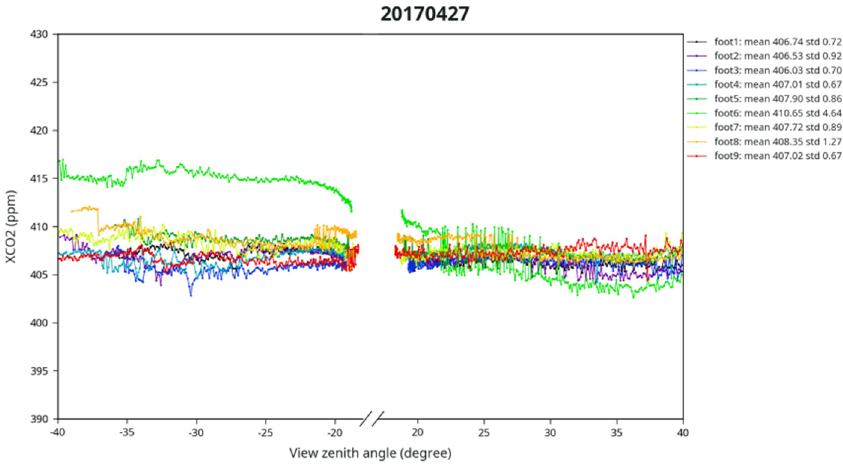
Figure 9. The retrieved XCO 2 of all 9 TanSat footprints over Dunhuang on 27 April 2017.